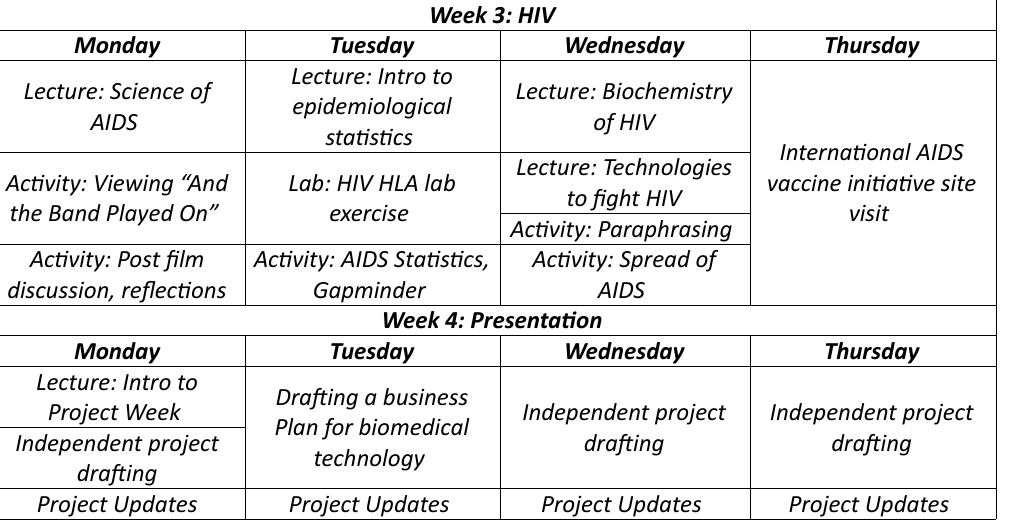
Table 1. Lesson plan schedule for the